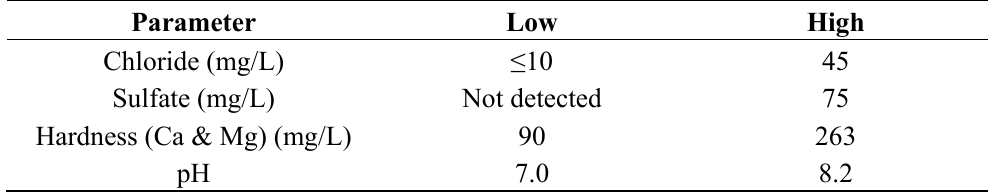
Table 1. Variations in the municipal water chemistry in 2010 for Santa Fe,